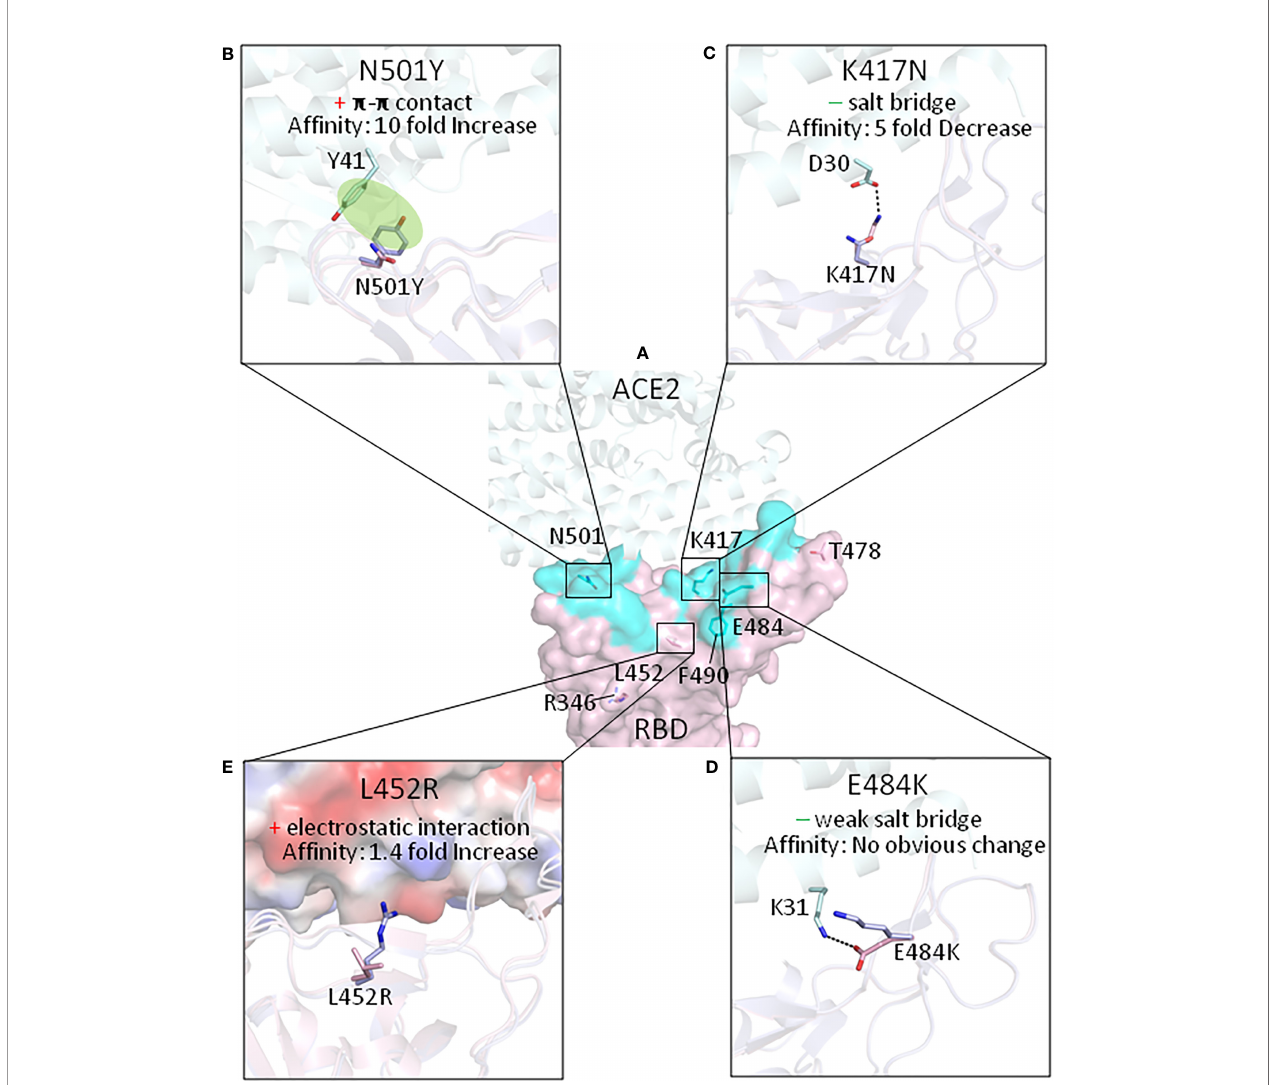
FIGURE 1 | The effect of the mutations of RBDs on interactions with ACE2, for currently identi fi ed SARS-CoV-2 VOC and VOI (with the exception of the Omicron variant). (A) The amino acids which have been mutated in the RBD variants are shown on the ancestral RBD with ACE2 in light cyan. Key mutations that affect the af fi nity of the RBD for ACE2 af fi nity are shown in (B) N501Y mutation; (C) K417N mutation; (D) E484K mutation; and (E) L452R mutation. “ + ” means gain of interaction while “ − ” indicates loss of interaction. The protein structures we used for modeling are from PDB with the following ID. Ancestral RBD: 6M0J, Alpha variant RBD: 7EKG, Beta variant RBD: 7EKG, Delta Variant RBD: